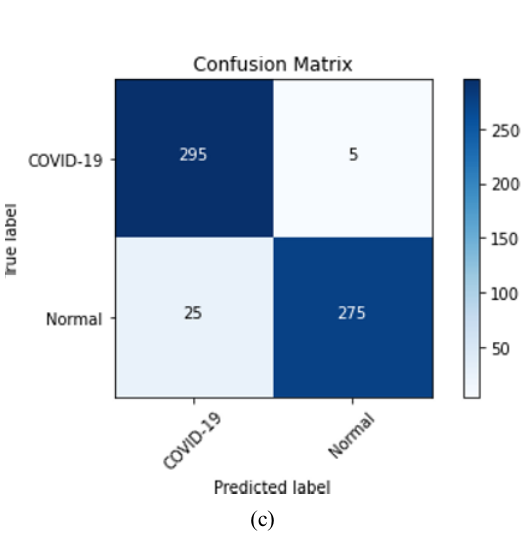
Fig. 4. Confusion matrix (a) using CNN, (b) using histogram equalization combined with CNN, (c) using a MobileNet